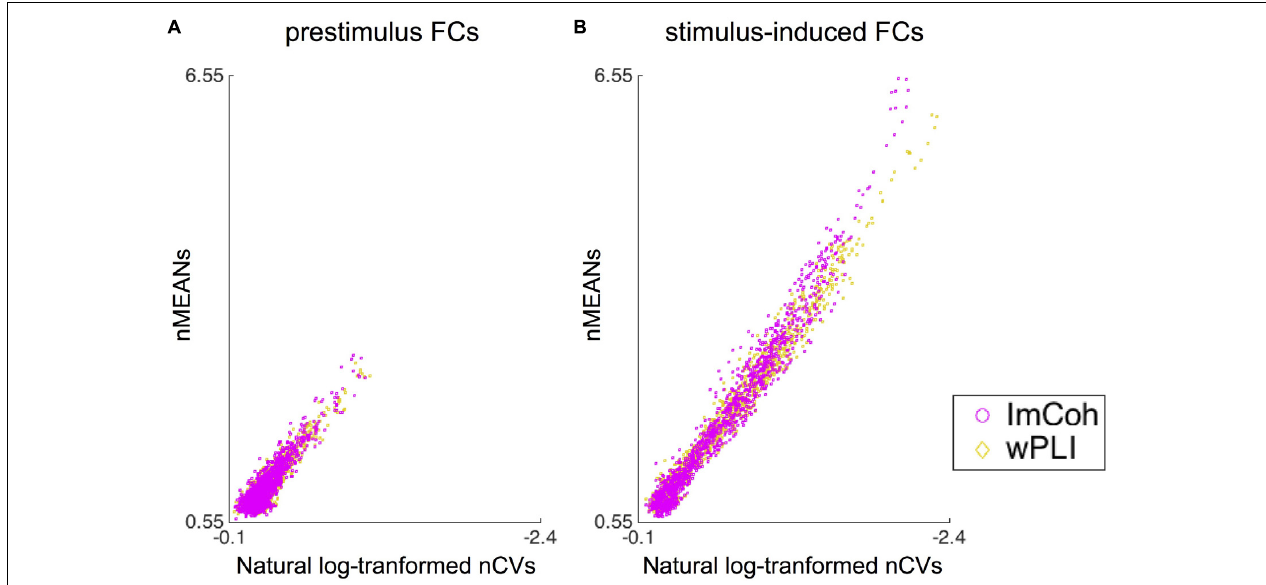
FIGURE 6 | Results of the descriptive statistics analysis. (A) Dot plots of means against natural log-transformed coefficients of variance of normalized functional connectivity (FC) values retrieved from the prestimulus FC mask. The plots are well overlapping between ImCoh and wPLI. (B) Dot plots of means against natural log-transformed coefficients of variance of normalized FC values retrieved from the stimulus-induced FC mask. The dot plot of ImCoh appears gradually shifted upward and leftward in comparison with that of wPLI as means of normalized FC values become greater. Note that values increase from right to left in the x -axis of both plots. nMEANs, means of normalized FC values; nCVs, coefficients of variance of normalized FC